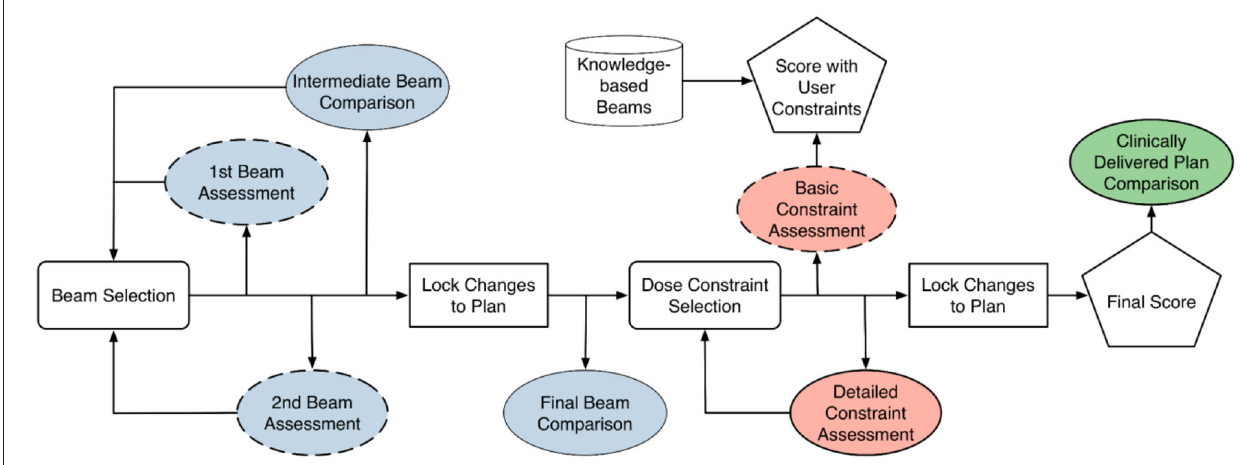
FIGURE 4 | Training diagram that is largely based on comparison between trainee’s results and knowledge-based planning (KBP) models. Blue-colored process is geometry-based assessment. Red-colored process is objective-based assessment. Green-colored process is geometry and objective based assessment. Dashed box is considered optional step. Cylindrical block is based on knowledge-based